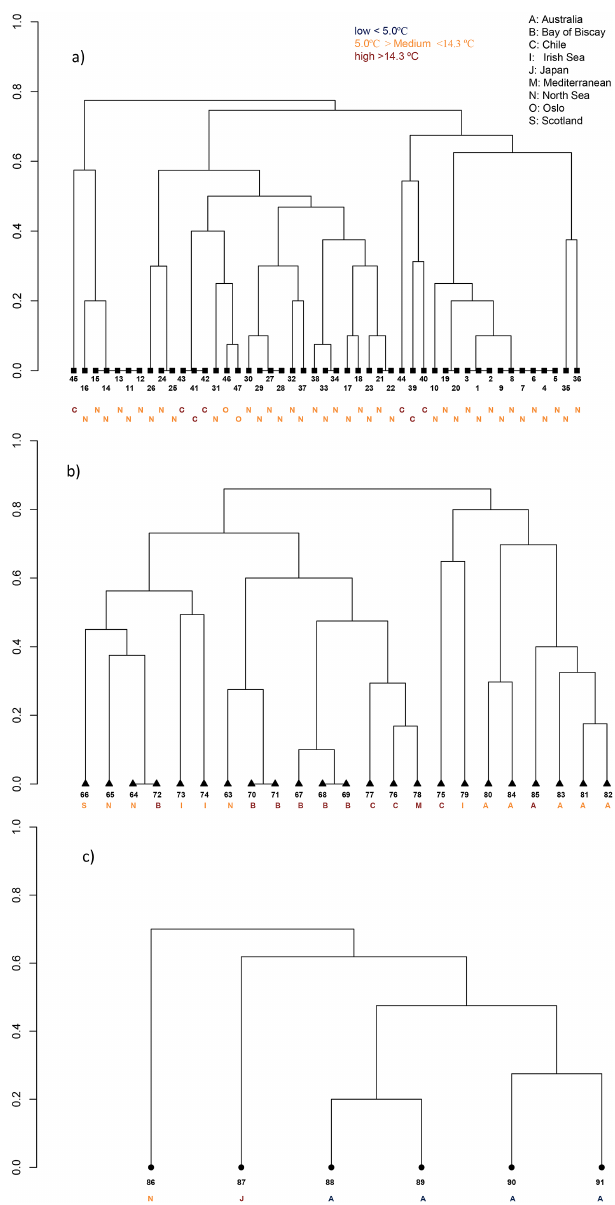
Figure 7. Multi-dimensional scaling plots constructed using the Bruvo et al. (2004) genetic distance, creating a 2-dimensional repre- sentation of the dissimilarity matrix used for the permutational mul- tivariate analysis of variance (ADONIS community ecology pack- age in R) in the biogeographic group: (a) CMM I, (b) CMM IV and (c) CMM